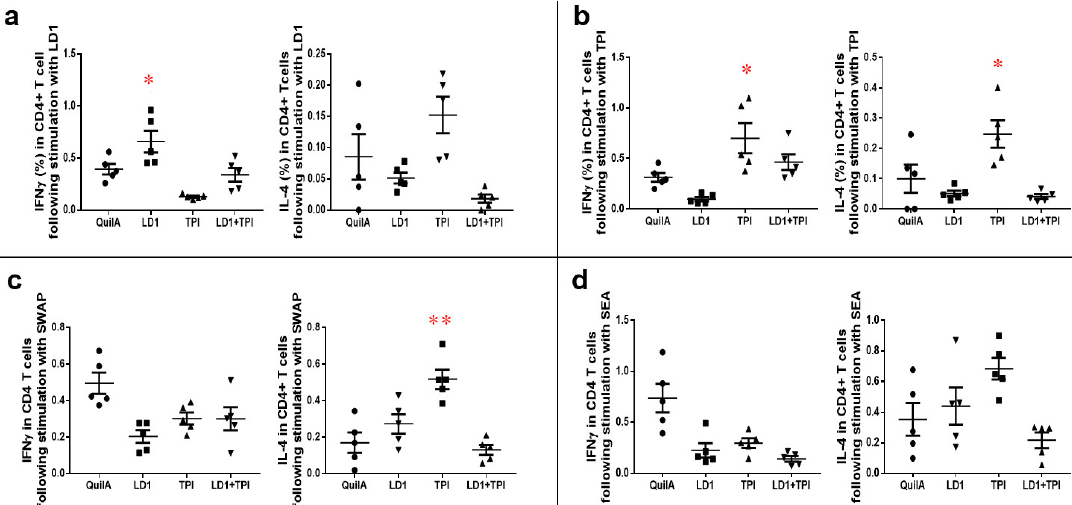
Figure 3. Cytokine profiles of splenic CD4 + T cells recovered from mice vaccinated with SjLD1, SjTPI